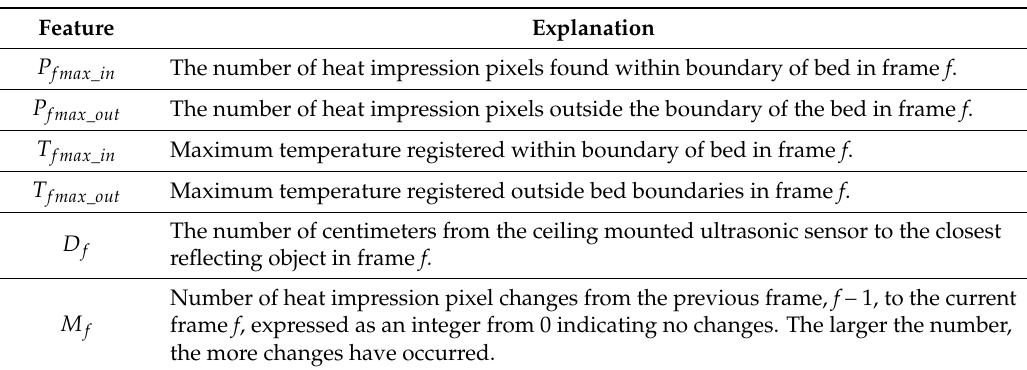
Table 1. Frame features extracted for further